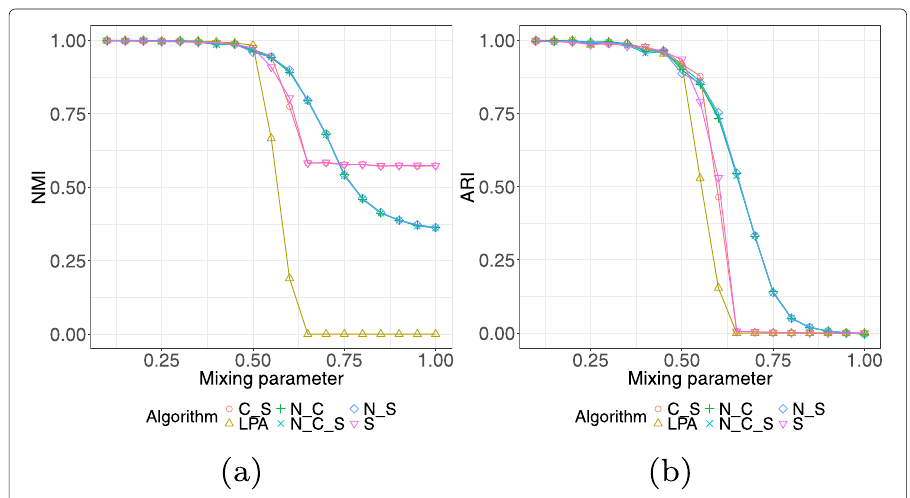
Fig. 2 Experiments on the LFR benchmark. All variations, except the classical LPA, implement memory. N: node preference, C: cutoff operator, S: synchronous update. Experiments are run 20 times and results averaged